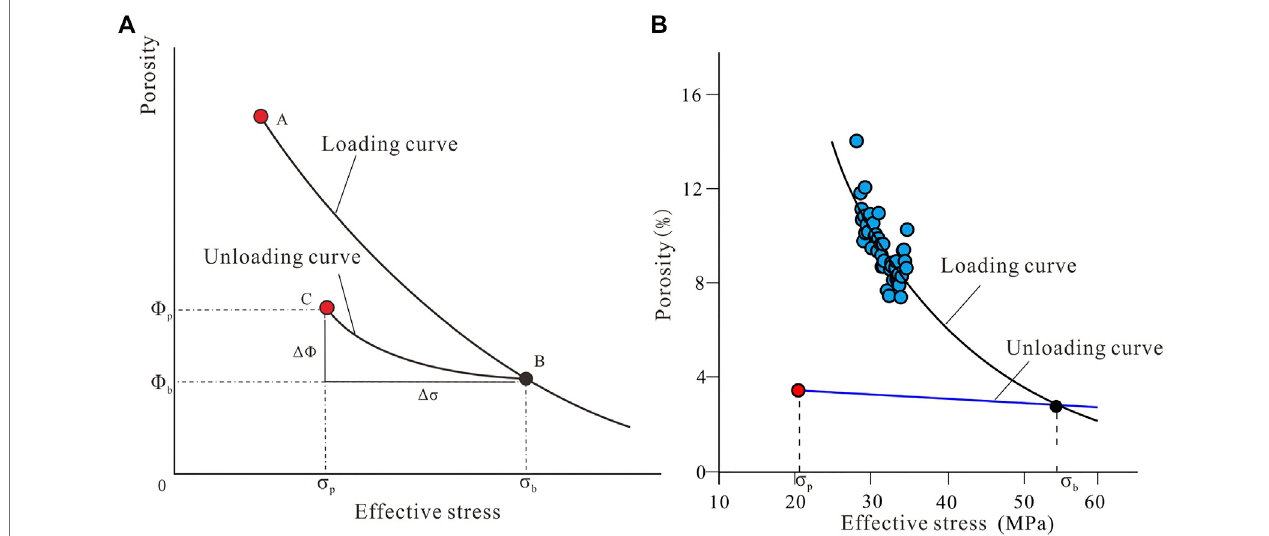
FIGURE 7 | (A) The loading and unloading curves model and (B) loading and unloading curves of Well Z in the Longdong